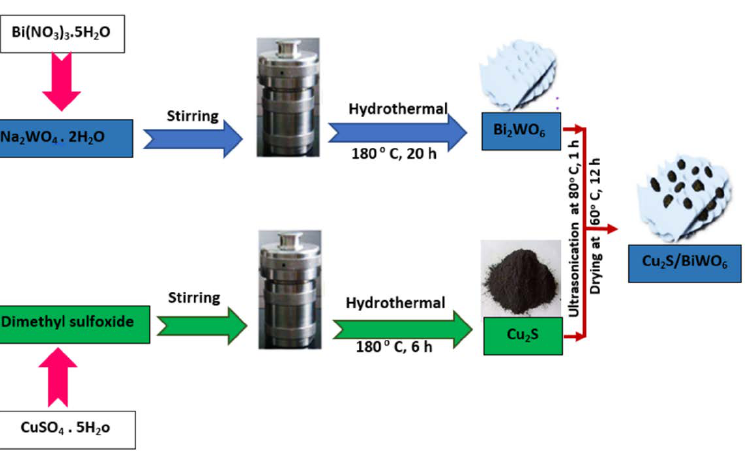
Figure 17. Schematic illustration of production route of hierarchical Cu 2 S/ Bi 2 WO 6 photocatalysts.